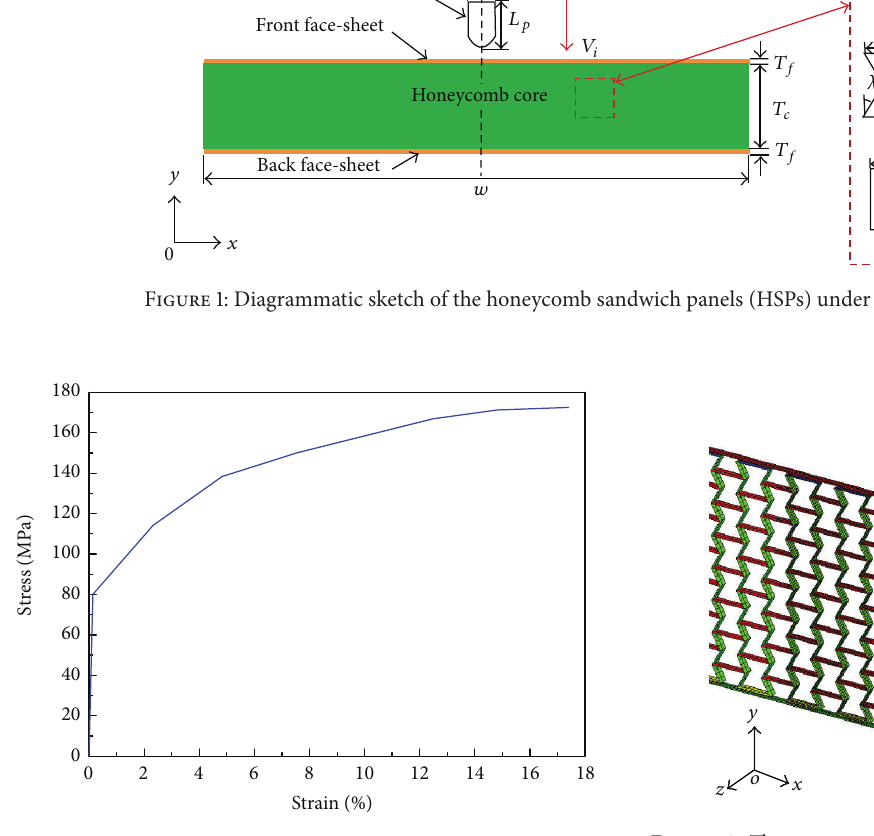
Figure 2: Tensile stress-strain curve of HSP material AA6060 T4. Figure 3: The representative FE model of the HSP (part) under projectile